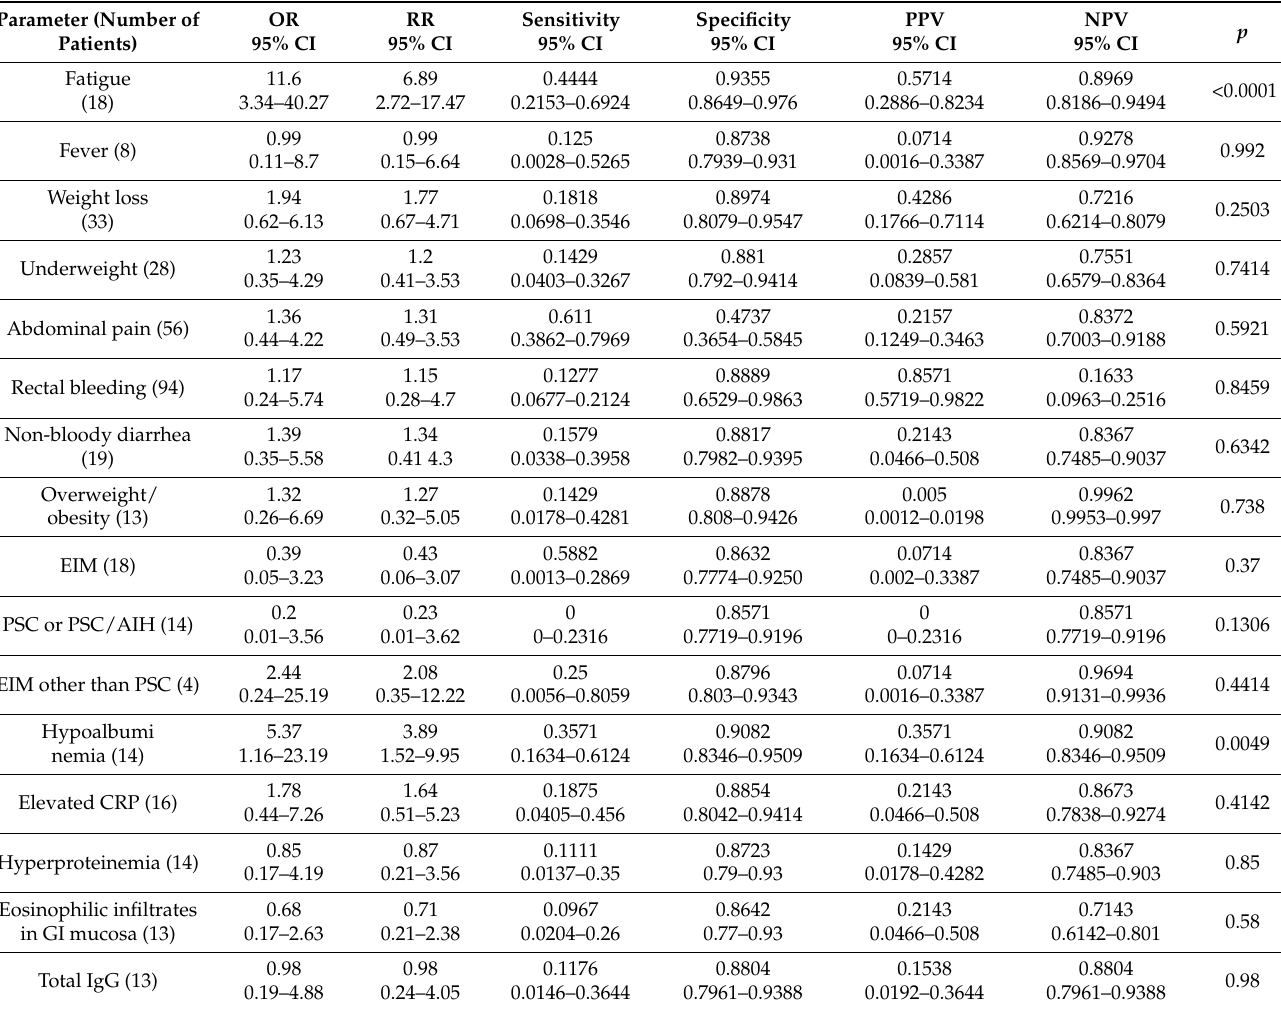
Table 6. UC additional tests results. In brackets the number of patients presenting with the